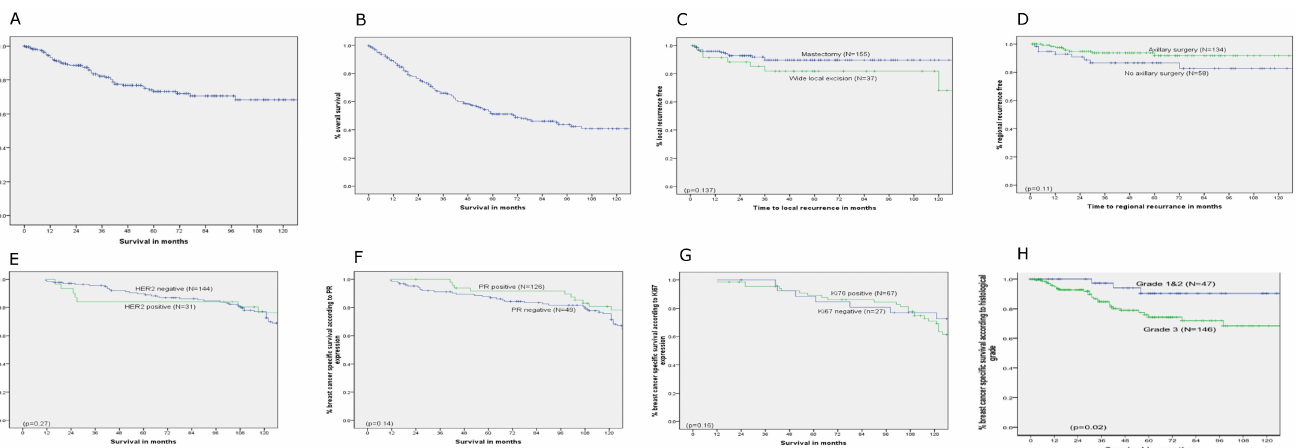
PLOS ONE | https://doi.org/10.1371/journal.pone.0188528 December28,